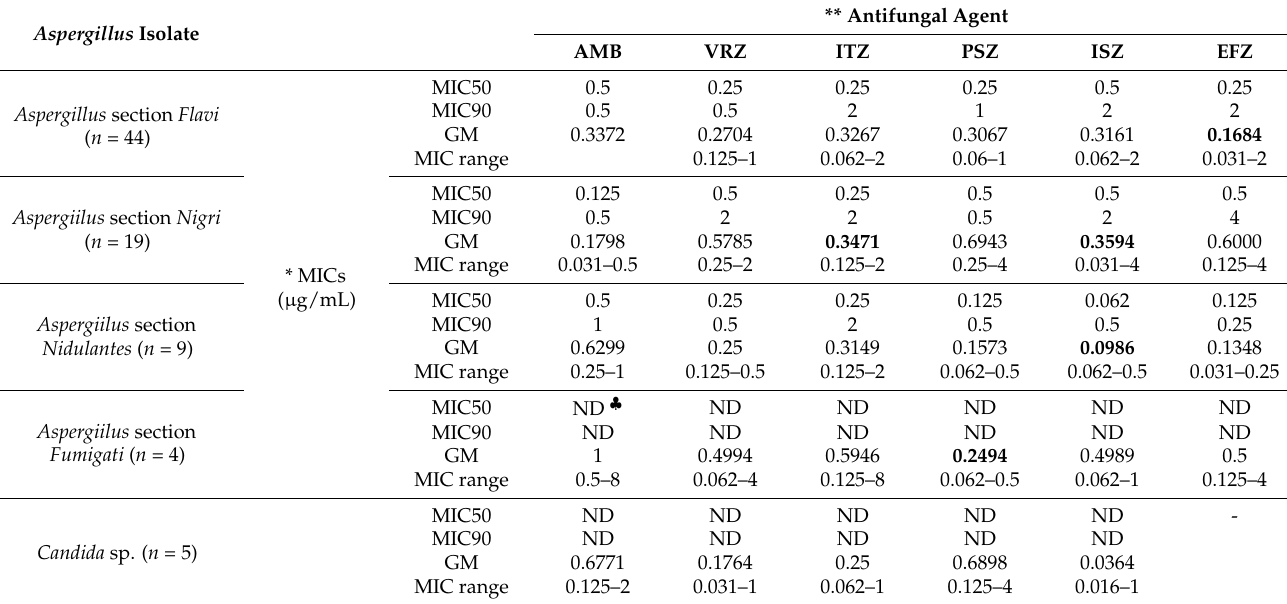
Table 3. Antifungal susceptibility profile of Aspergillus species isolated from